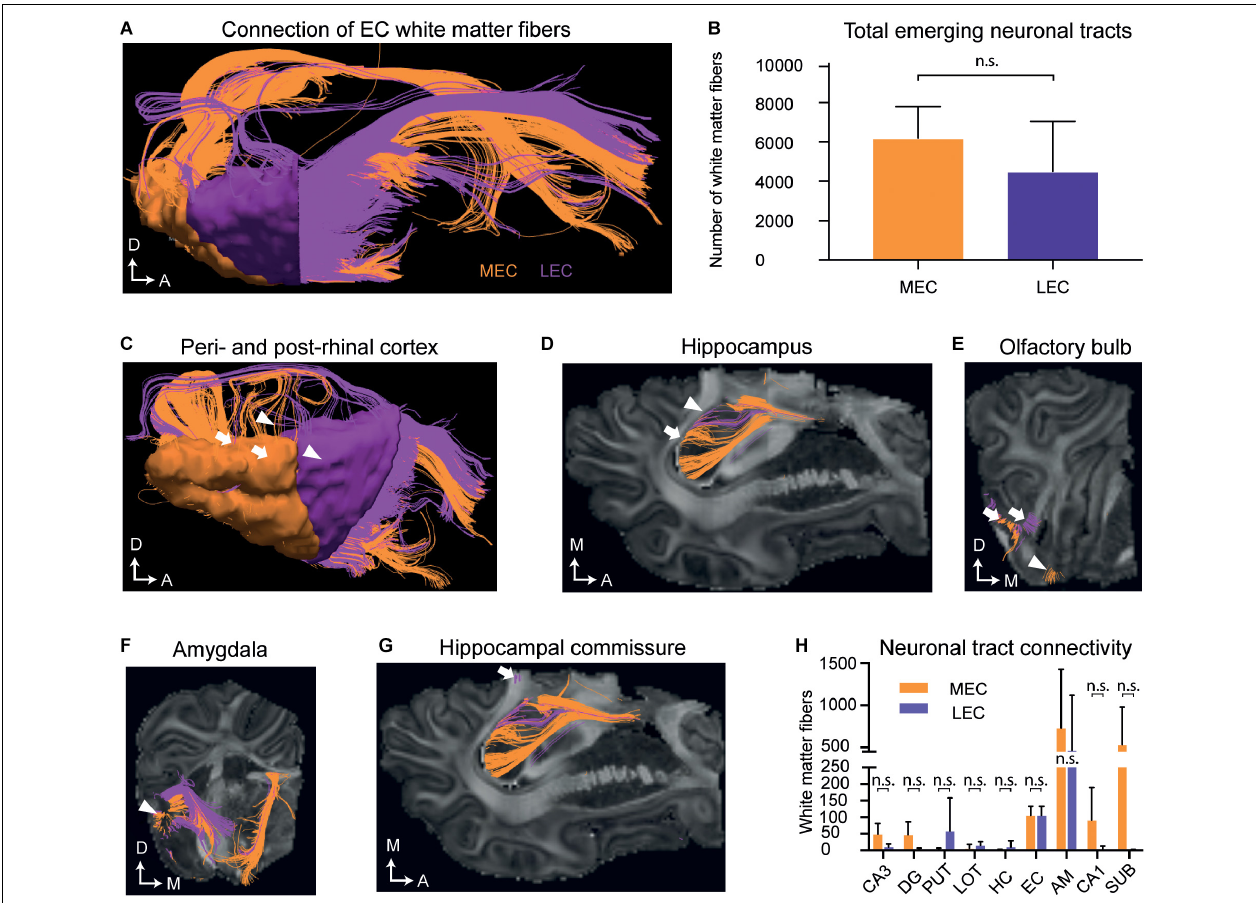
FIGURE 5 | Diffusion tensor imaging (DTI) of the white matter projections identify white matter fiber projections to varying brain regions at postnatal day (P)75. (A) An overview of white matter fibers connecting to/from the medial entorhinal cortex MEC (orange) and laternal entorhinal cortex LEC (purple). (B) The average number of tracts connecting to/from the MEC and LEC do not differ significantly. (C) White matter fibers connecting to/from the perirhinal cortex (white triangles) and postrhinal cortex (white arrows). (D) White matter fibers connecting to the hippocampus (white arrows). (E) White matter fibers connecting to the lateral (white arrows) and medial olfactory bulb (white triangle). (F) White matter fibers connecting to the amygdala (white triangle). (G) White matter fibers extend from the EC to the hippocampal commissure (white arrow). Axes: A, Anterior; D, Dorsal, M, Medial. (H) The average number of tracts connecting to different anatomical regions emerging from the EC do not significantly differ between the MEC and LEC. All error bars denote SD. n.s, not significant. Significance threshold, p ≤ 0.05. AM, amygdala; DG, dentate gyrus; EC, entorhinal cortex; HC, Hippocampal commissure; LOT, lateral olfactory tract; PUT, putamen; SUB,